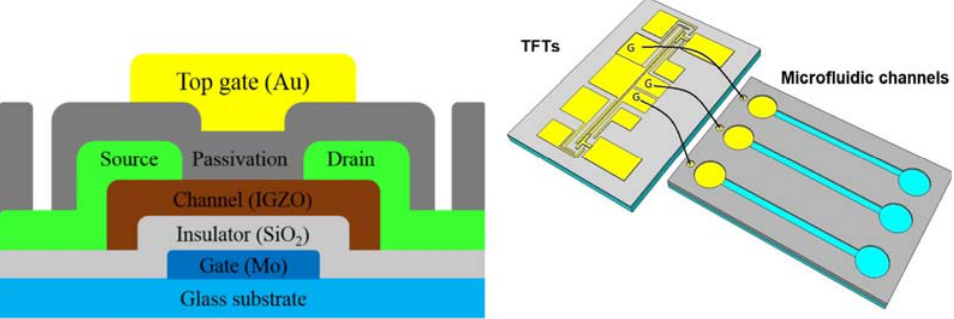
Figure 6. On the ( left ), the cross ‐ sectional view of the FET sensor and on the ( right ), the integrated system formed by a microfluidic chip with three channels and an integrated circuit containing three n ‐ type MOSFETs. Reprint by permission from Elsevier.